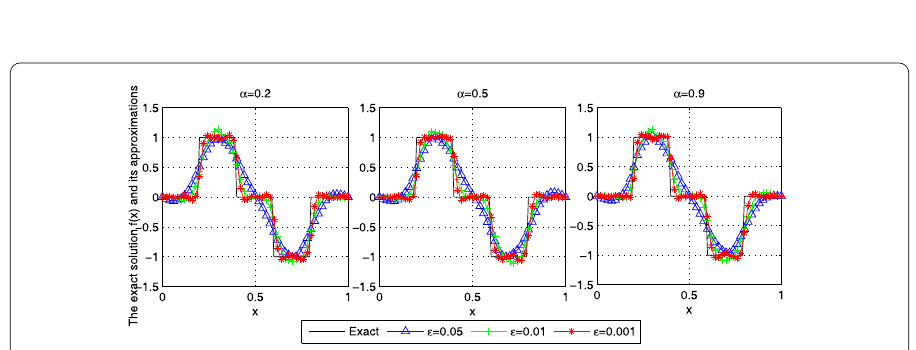
Figure 2 The comparison of numerical effects between the exact solution and its regularized solution for Example 2.